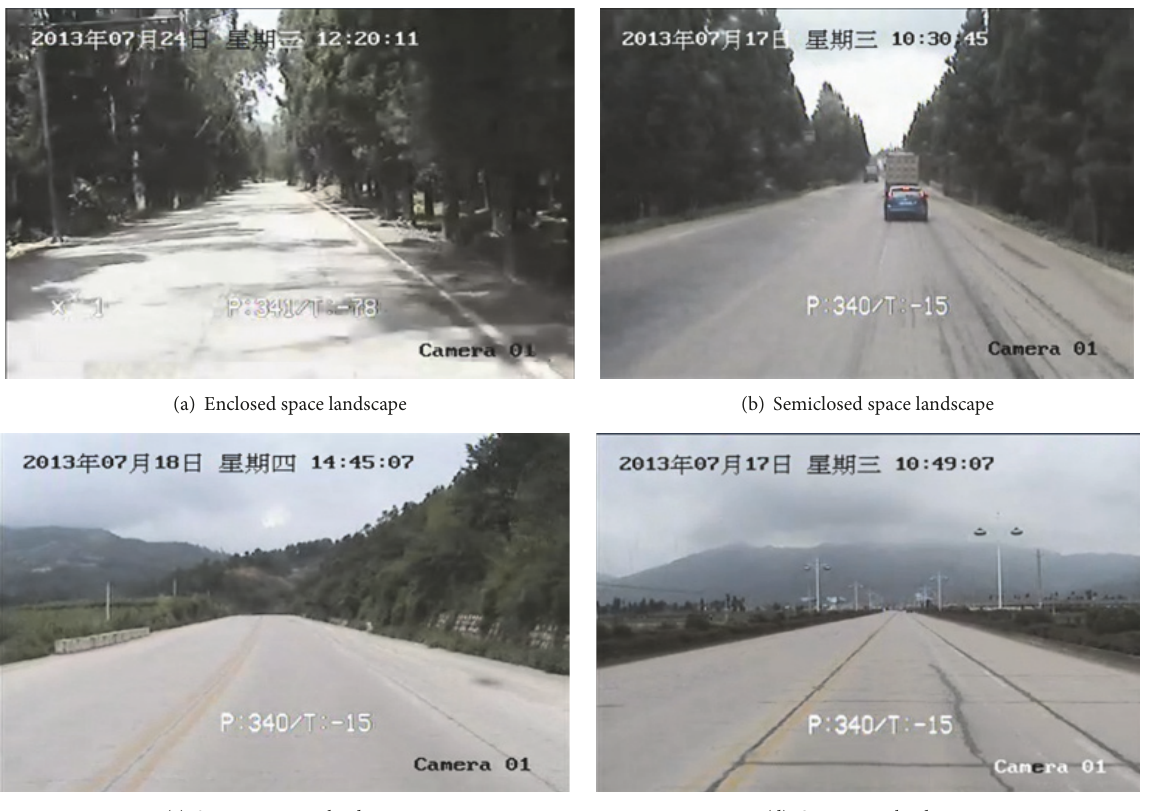
Figure 3: Four types of highway landscapes.